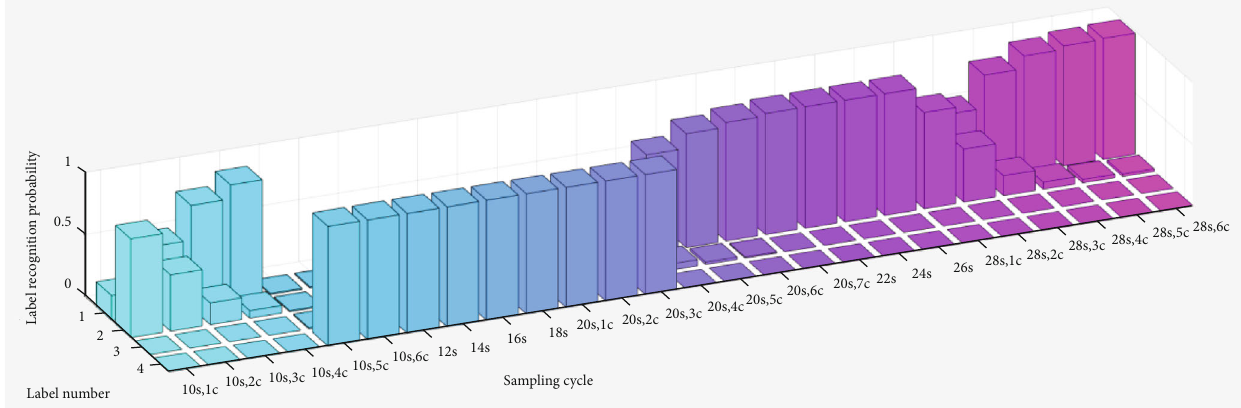
Figure 12: Mobile occupancy recognition probability. The x -axis is the time axis, the y -axis is the maneuver occupancy feature, and the z -axis is the recognition probability of the